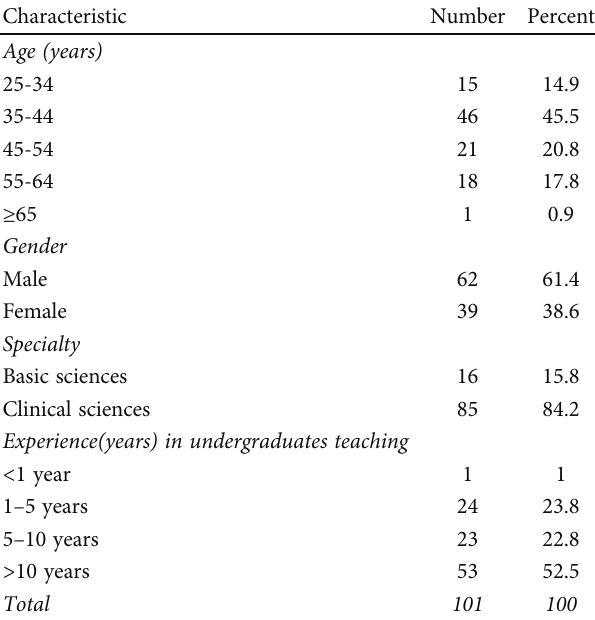
Table 1: Characteristics of the study